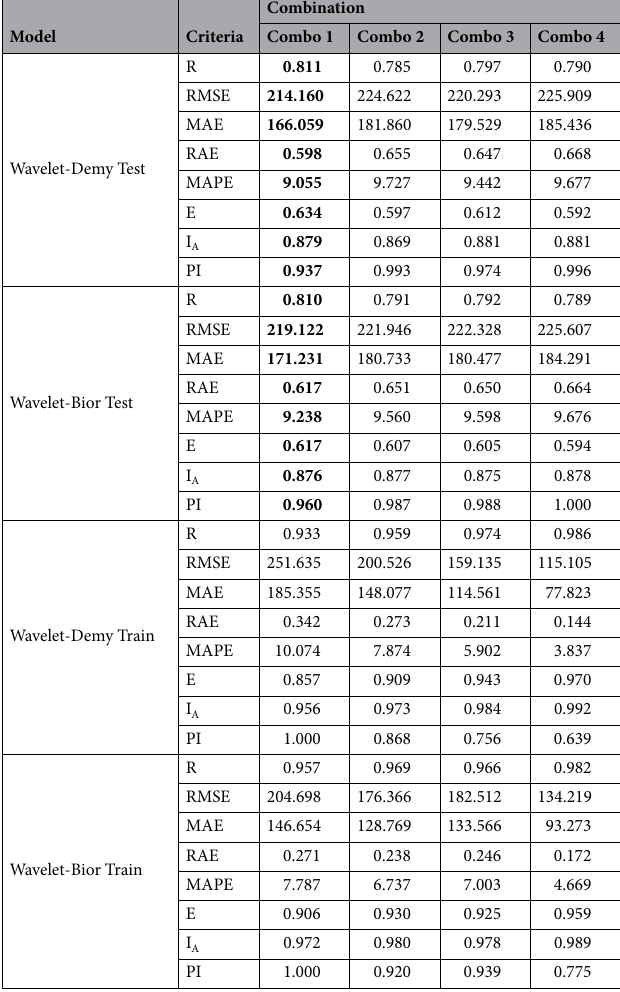
Table 11. Statistic metrics obtained by W-GRNN model to forecast the EC parameter for all combinations. Significant values are in